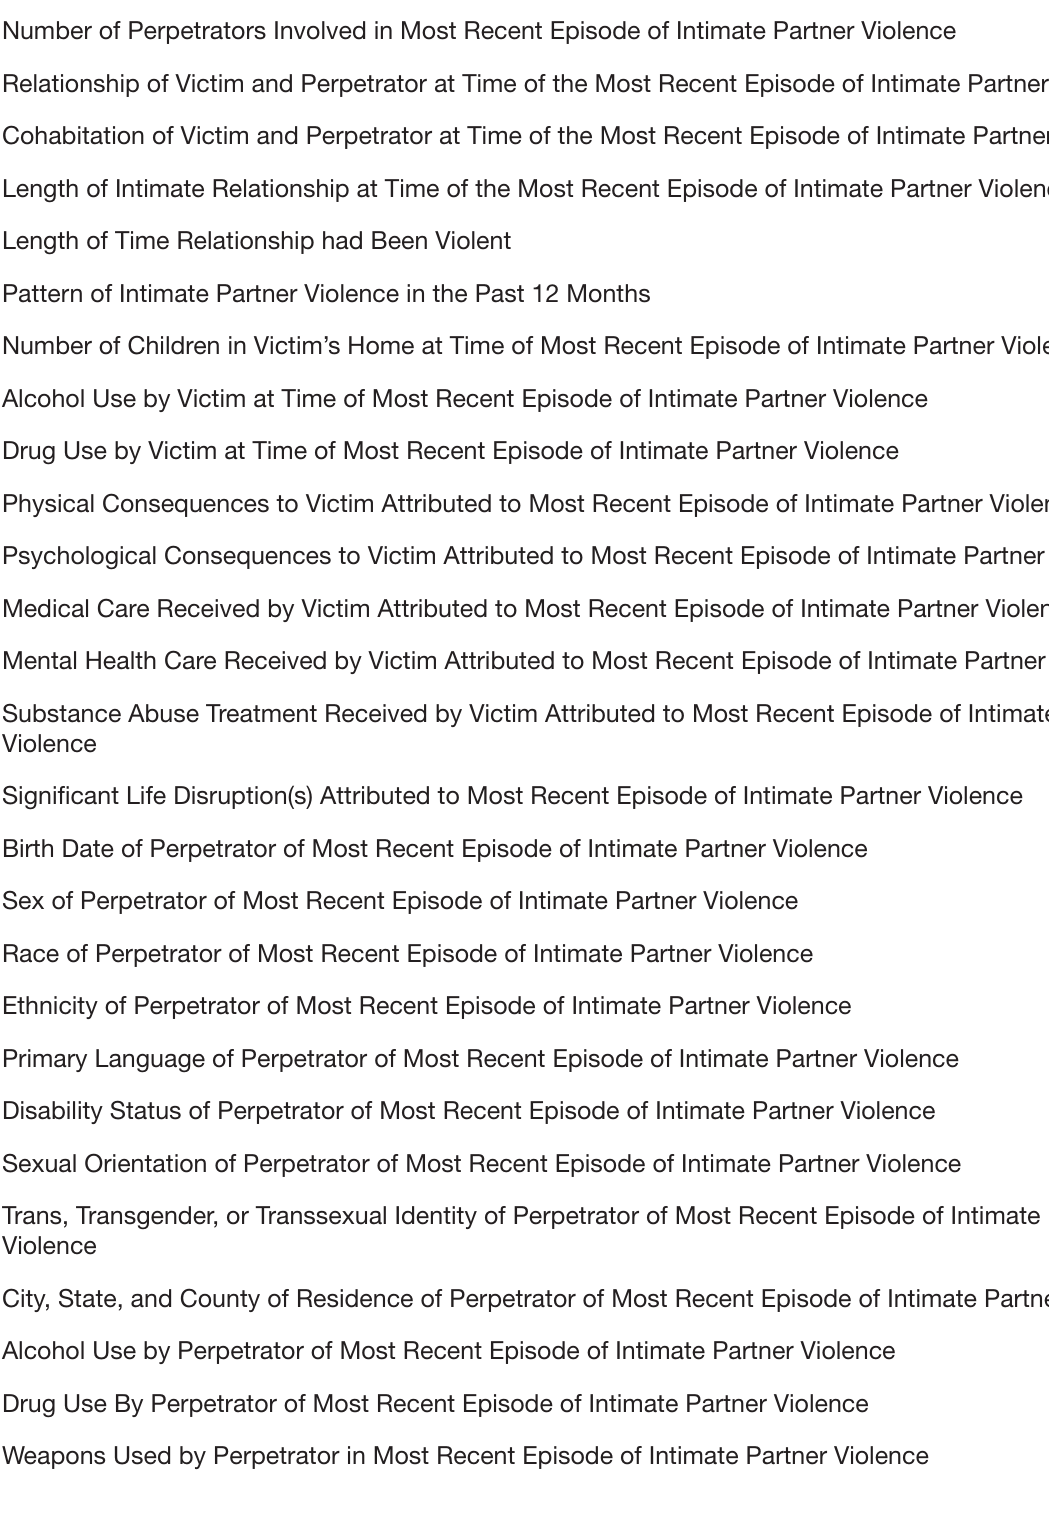
INTIMATE PARTNER VIOLENCE: UNIFORM DEFINITIONS AND RECOMMENDED DATA